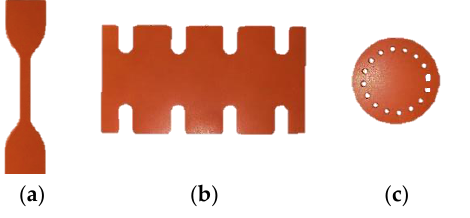
Figure 4. Silicone rubber coupon tests samples for validation study: ( a ) uniaxial test, ( b ) planar test, and ( c ) equibiaxial test.